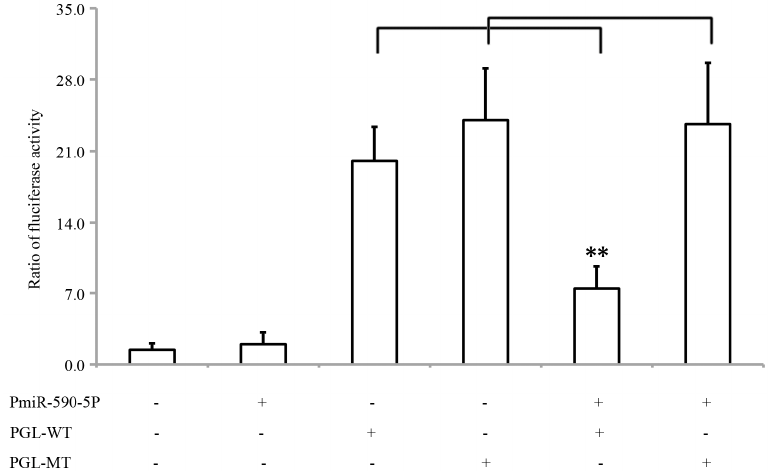
Figure 2. The 3'UTR of S100A10 enables miR-590-5P regulation. 293 cells were transfected with pmiR-590-5P construct with or without pGL-WT or pGL-MT. The histogram indicates relative firefly luciferase activities in the different transfected groups. Error bars represent standard deviation and were obtained from three independent experiments **, t -test significant at p < 0.01.